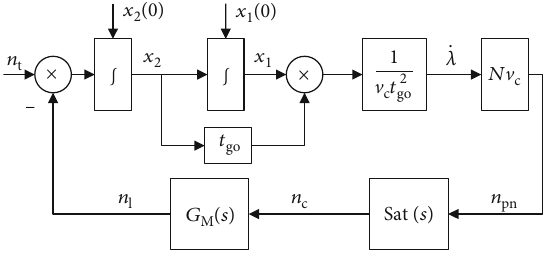
Figure 8: Block diagram of the analytic terminal guidance